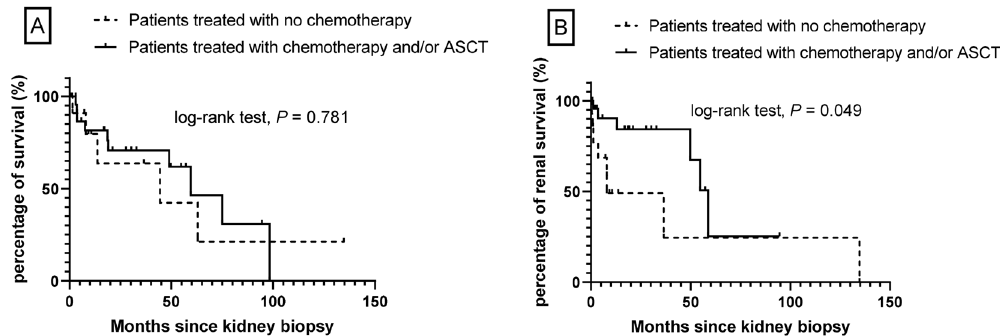
Figure 2. ( A ) Comparing survival of IgM-MGRS patients treated with or without chemotherapy and/or ASCT. ( B ) Comparing renal survival of IgM-MGRS patients treated with or without chemotherapy and/or